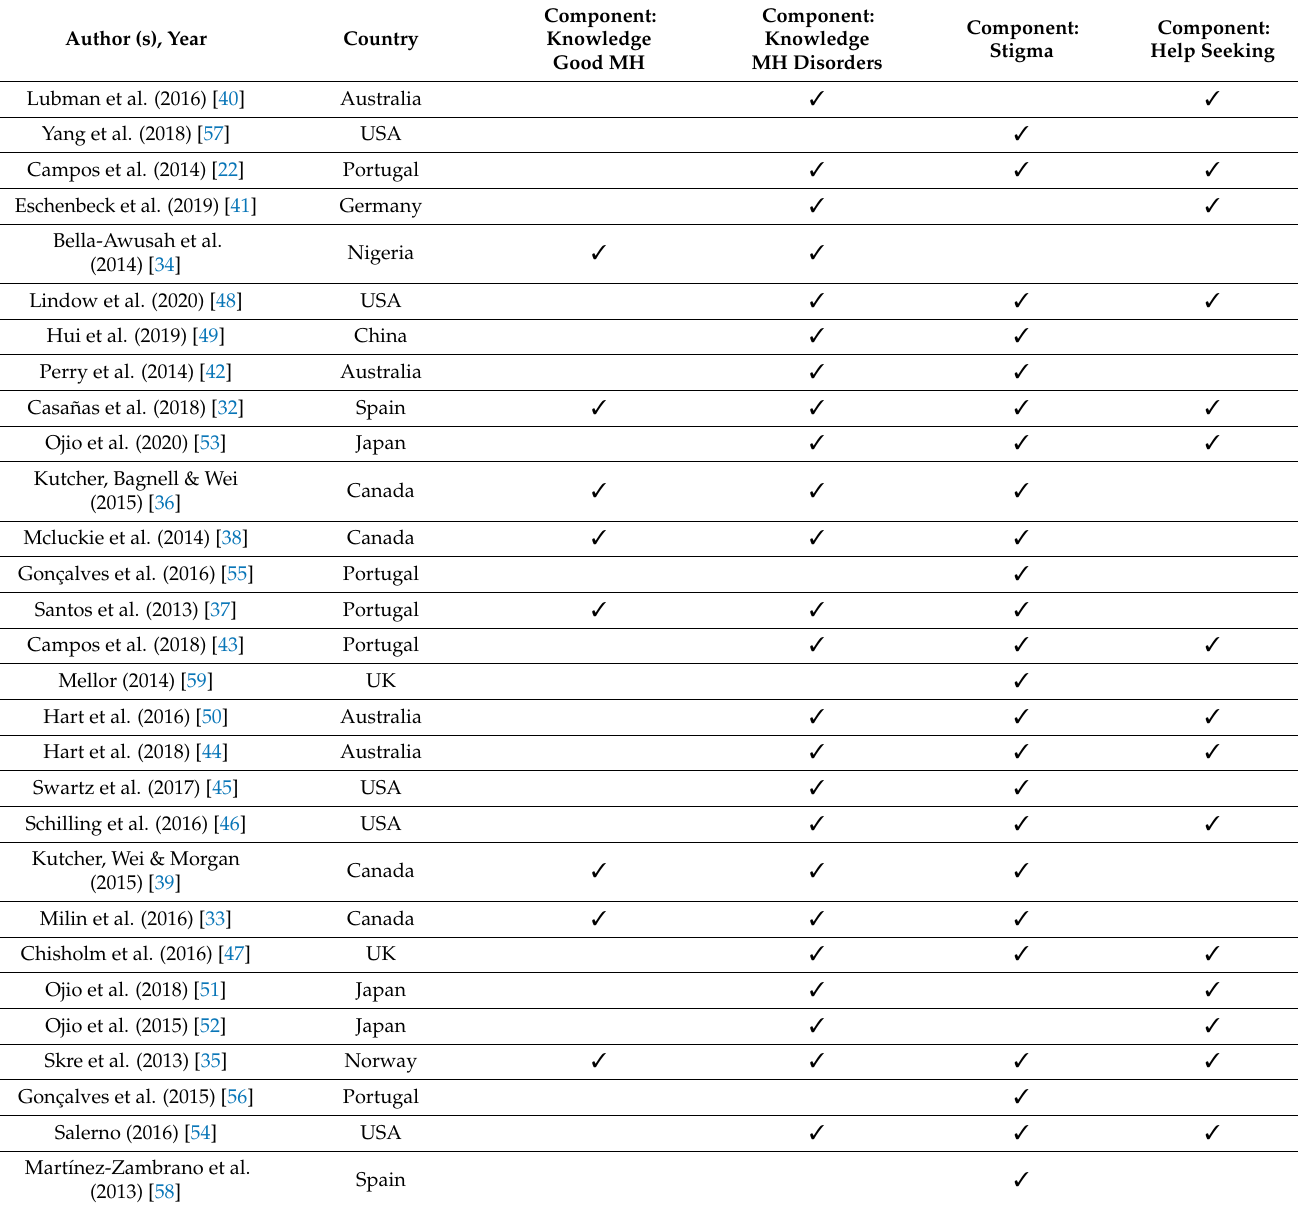
Table 3. List of studies included in the review according to the components of